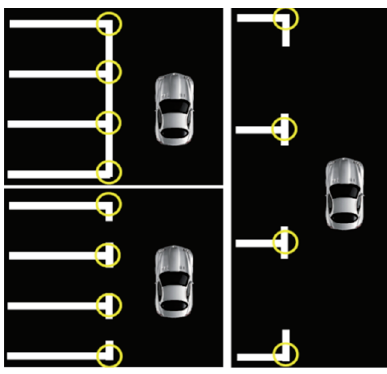
Figure 4. The "L" and "T" corner points.